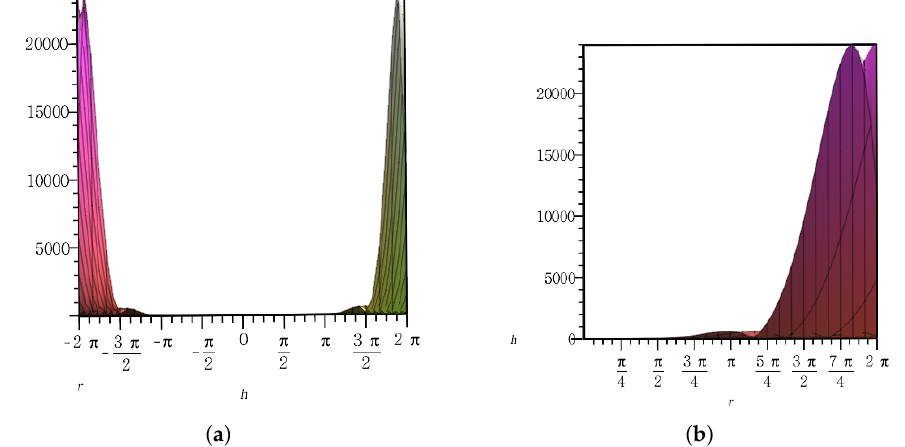
Figure 4. ( a ) Side view of Figure 3a observed in the direction perpendicular to h . ( b ) Side view of Figure 3a observed in the direction perpendicular to r